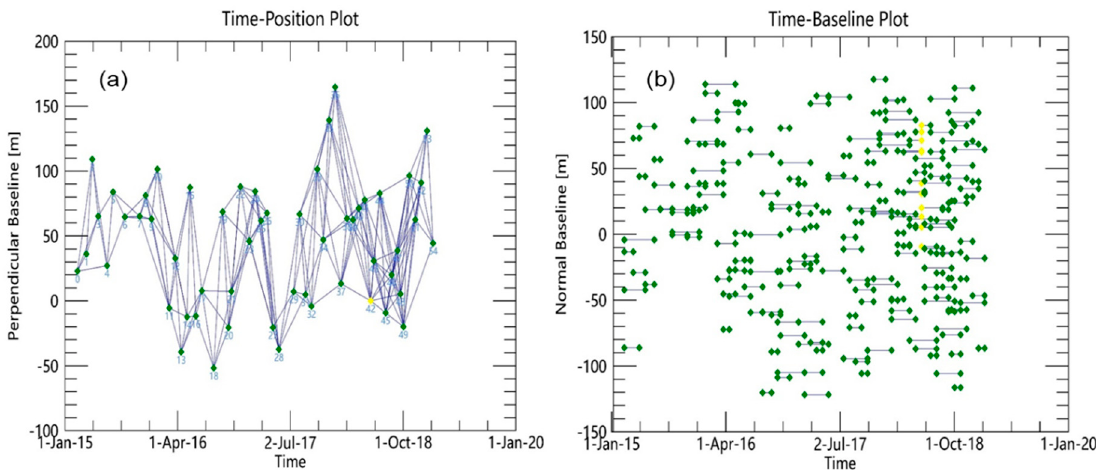
Figure 3. ( a ) Time-position of Sentinel-1A acquisitions and ( b ) time-baseline of Sentinel-1A interferometric pairs. Each green diamond denotes a slave image, each yellow diamond represents a super master image and each line represents a connection.